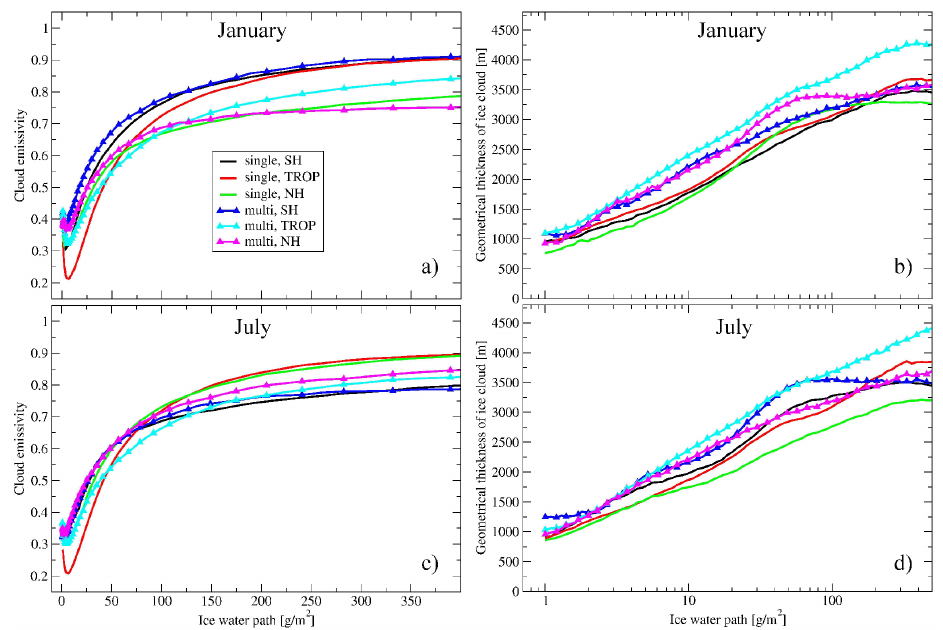
Figure 4. Average cloud emissivity and ice cloud layer vertical extent as a function of ice water path, separately for single and multi-layer clouds and three latitude zones, for 2 months (January 2007: a , b , and July 2007: c , d ). All four panels share the same legend, SH (Southern Hemisphere), TROP (tropical type atmosphere), and NH (Northern Hemisphere) correspond to latitude zones 90–30 ◦ S, 30 ◦ S–30 ◦ N, and 30–90 ◦ N,